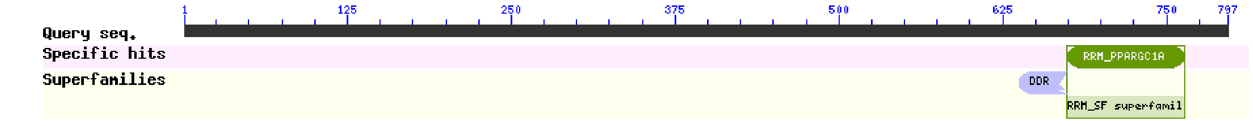
Figure 3. Putative conserved functional domain of buffalo PPARGC1A.